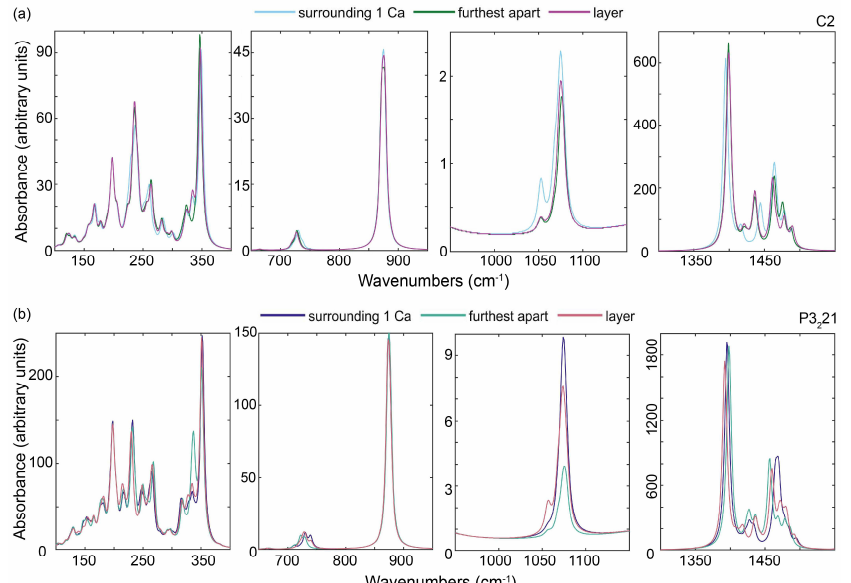
Figure 5. Calculated band shifts and intensity changes associated with the distribution of 18 O in C 16 O 218 O vaterite infrared spectra: ( a ) C2 structure and ( b ) P3 2 21 structure. The regions outside of the plotted areas have no vibrational bands visible. Note that the individual spectral regions of interest are plotted with different y axes to facilitate visualization.